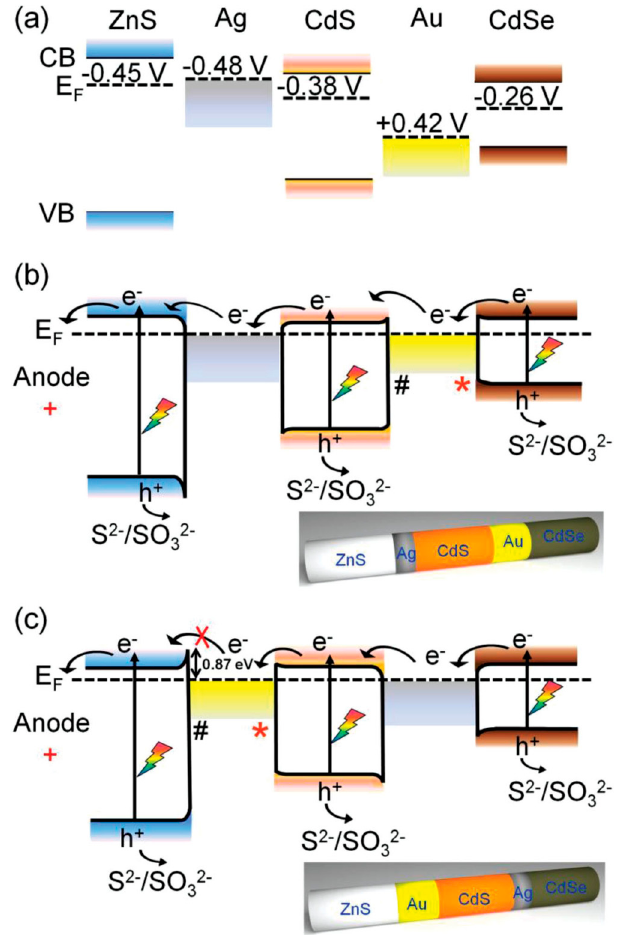
Figure 3. ( a ) Energy levels of ZnS, CdSe, CdS, Au and Ag ( vs. NHE); illustration of the interfacial PICT processes in ( b ) ZnSAg-CdS-Au-CdSe nano-bamboo and ( c ) ZnS-Au-CdS-Ag-CdSe nano-bamboo after heterostructuring. *: forward-bias Schottky junction; #: reverse-bias Schottky junction. Reproduced with permission [65]. Copyright 2015, Wiley.